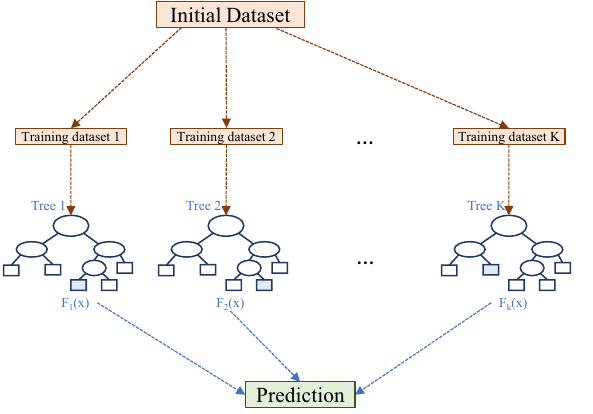
Figure 5. Sketch of the RF architecture.